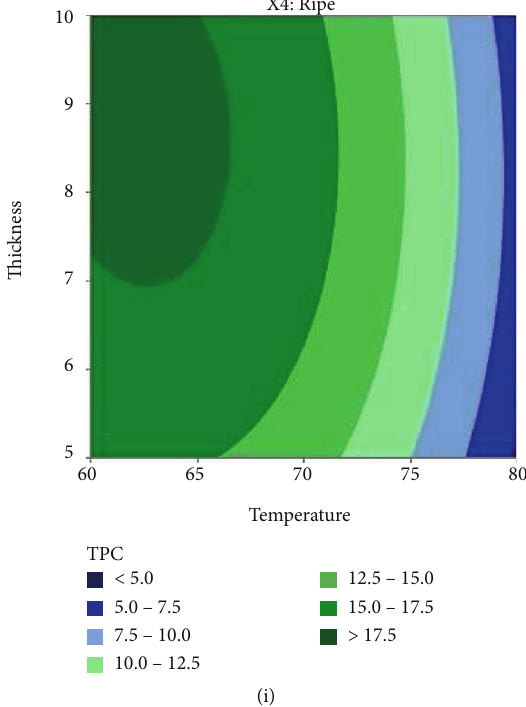
Figure 3: Contour plots of TPC as a function of time, temperature, and thickness for green, semiripe, and ripe papaya